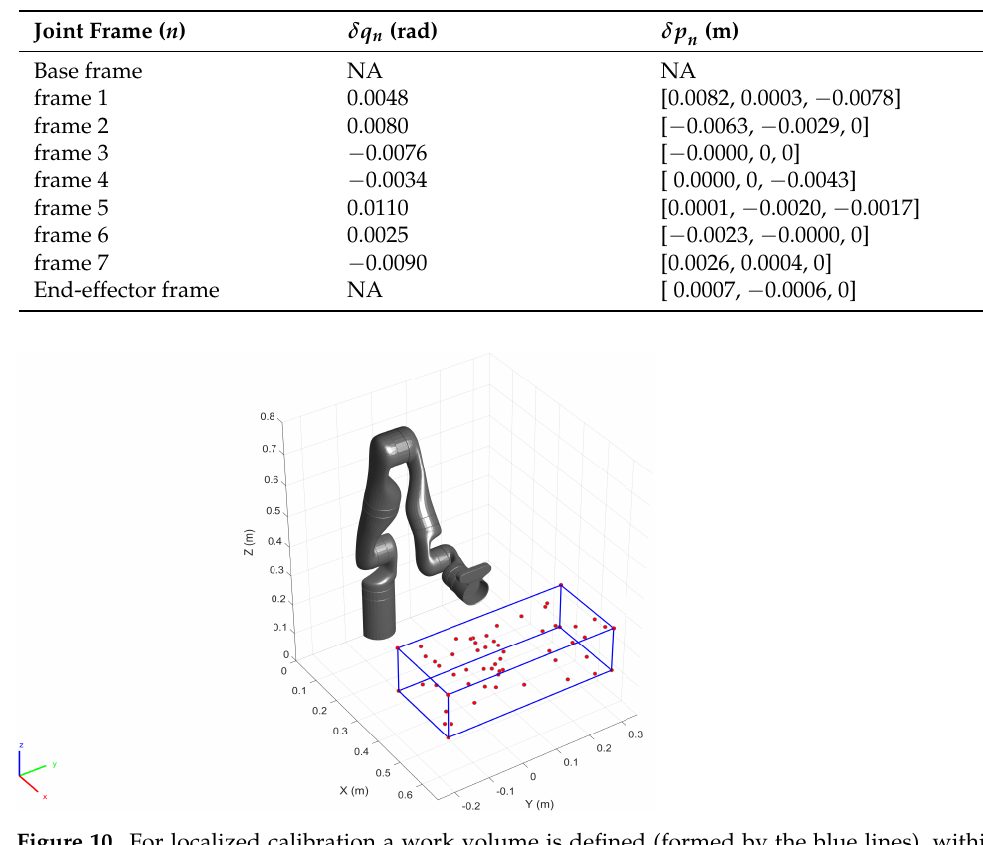
Figure 10. For localized calibration a work volume is defined (formed by the blue lines), within which 58 spatial points (red circles) were generated. The robot moves to each of the 3D points, and the simultaneous logging of the robot position and the orientation populate the training set.